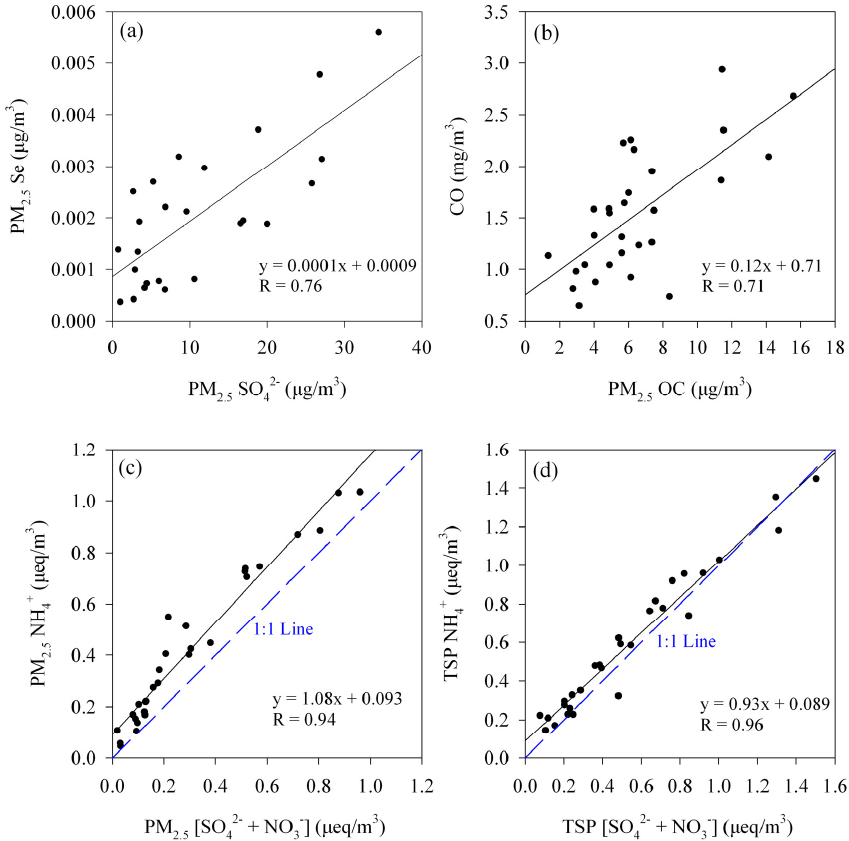
Fig. 6. The linear correlation between (a) Se and SO 42- in PM 2.5 (b) CO and PM 2.5 OC (c) the equivalent NH 4+ concentration and the sum of equivalent SO 42- and NO 3- concentration in PM 2.5 and (d) TSP. The dashed blue line denotes the 1:1 line.